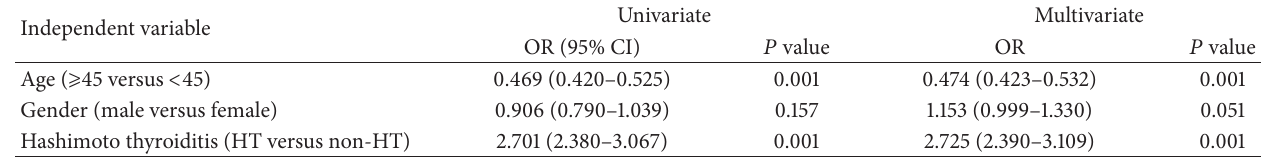
Table 2: Univariate and multivariate analysis for